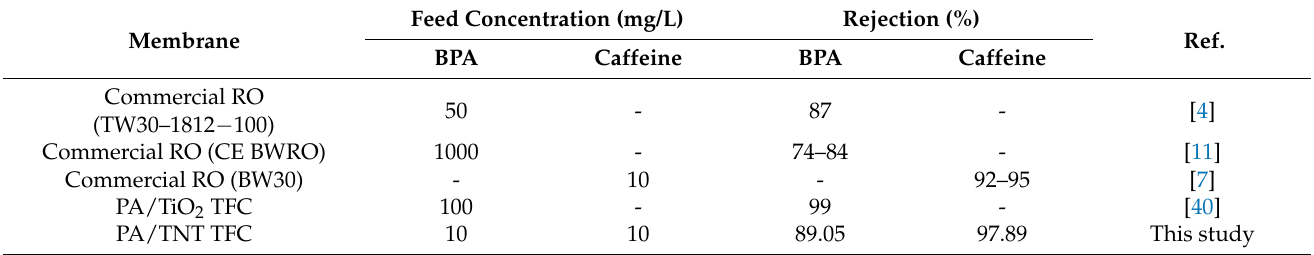
Table 2. Comparison of pristine TFC and modified TFN membrane performances based on their